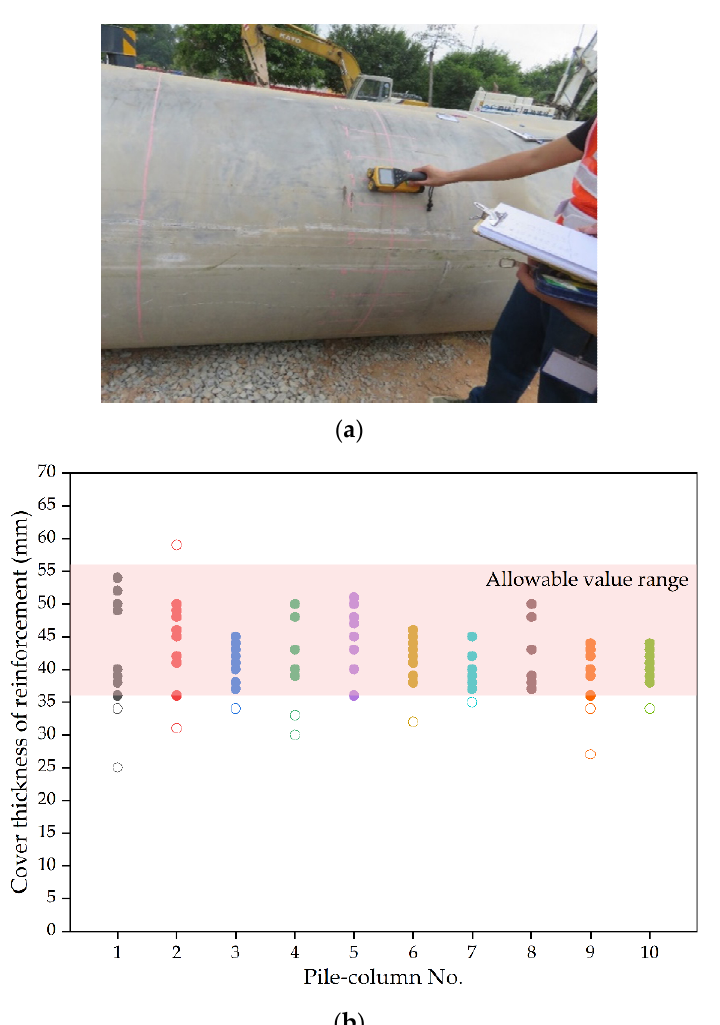
Figure 4. Cover thickness of reinforcement of prefabricated pile ‐ column: ( a ) the cover thickness monitoring test of a prefabricated pile ‐ column using a hand ‐ held steel bar scanner; ( b ) the cover thickness values of reinforcement for 10 prefabricated pile ‐ column specimens.